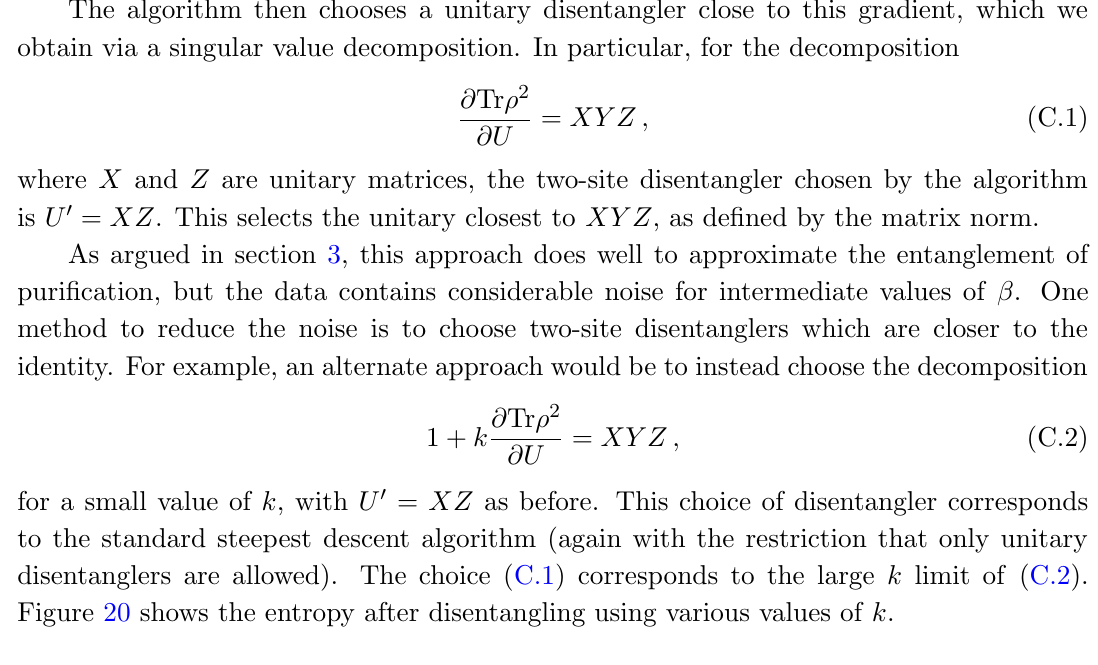
Figure 19. An illustration of the gradient operator @ Tr (cid:26) 2 represents (cid:2) or its conjugate. Every pair of connected ancilla legs is connected by the identity, while the disconnected set of legs represents the removed unitary